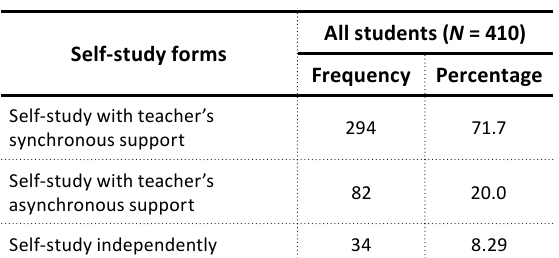
Table 6. Perceived form of effective self-study